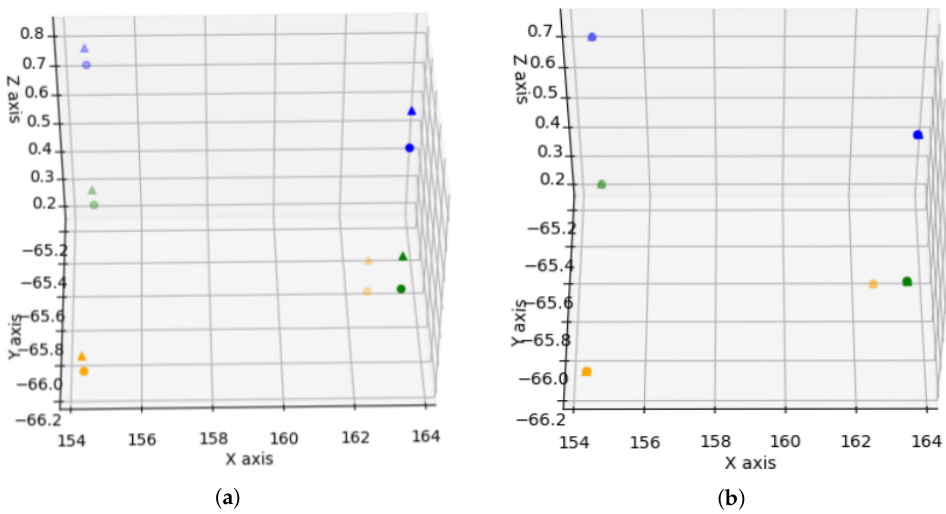
Figure 15. Odometry results with SVD: ( a ) Representation of the synthetic points extracted from the previous clusters. A translation and rotation between them is shown; and ( b ) synthetic points are overlapped when applying the rotation and translation calculated by SVD.